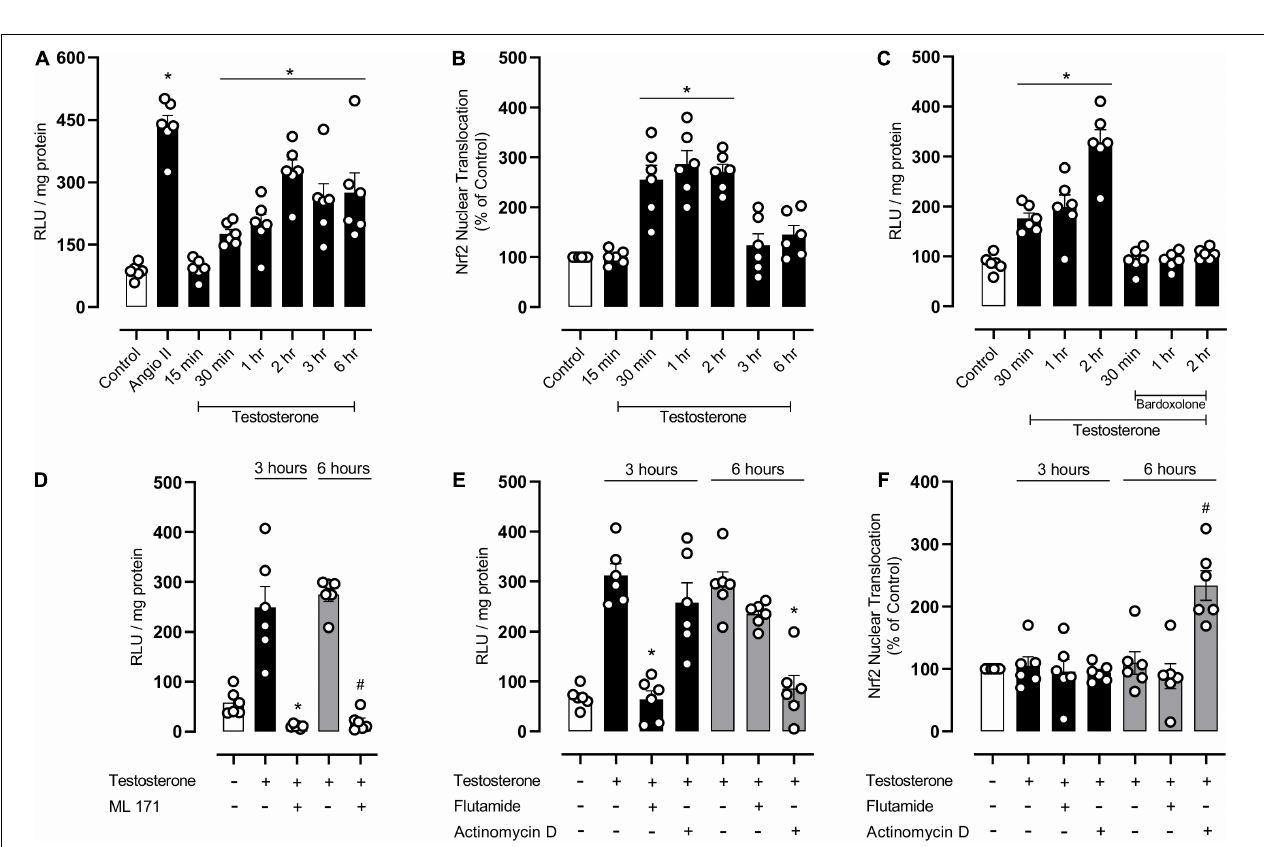
FIGURE 6 | Testosterone induces a biphasic increase in reactive oxygen species (ROS) generation by mechanisms that involves NOX1 activation and downregulation of nuclear factor E2–related factor 2 (Nrf2) activity in endothelial cells. Superoxide anion generation was measured by lucigenin [ (A,C–E) n = 6 or 7 for each experimental group] and nuclear accumulation of Nrf2 [ (B,F) n = 6 for each experimental group]. Data are expressed as mean ± SEM. * p < 0.05 vs . Control; # p < 0.05 vs . Testosterone.